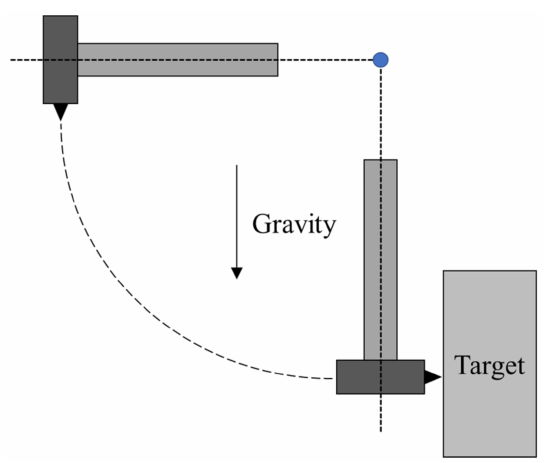
Figure 6. Impact force at input locations #1–#6.